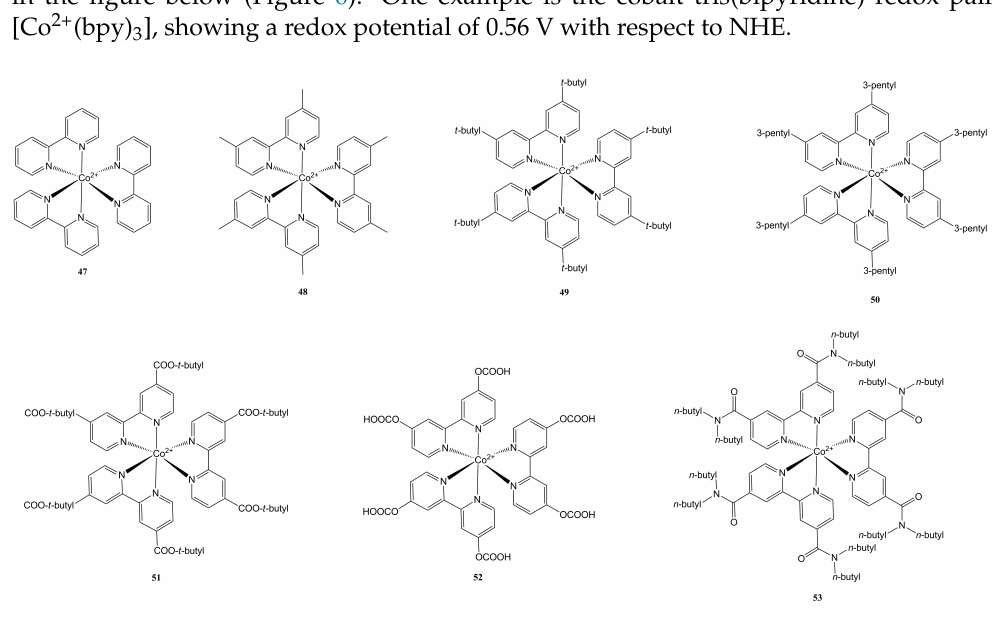
Figure 6. Examples of DSSCs containing Co 2+/3+ redox shuttles used in DSSCs. Reprinted from [41] with permission of John Wiley and